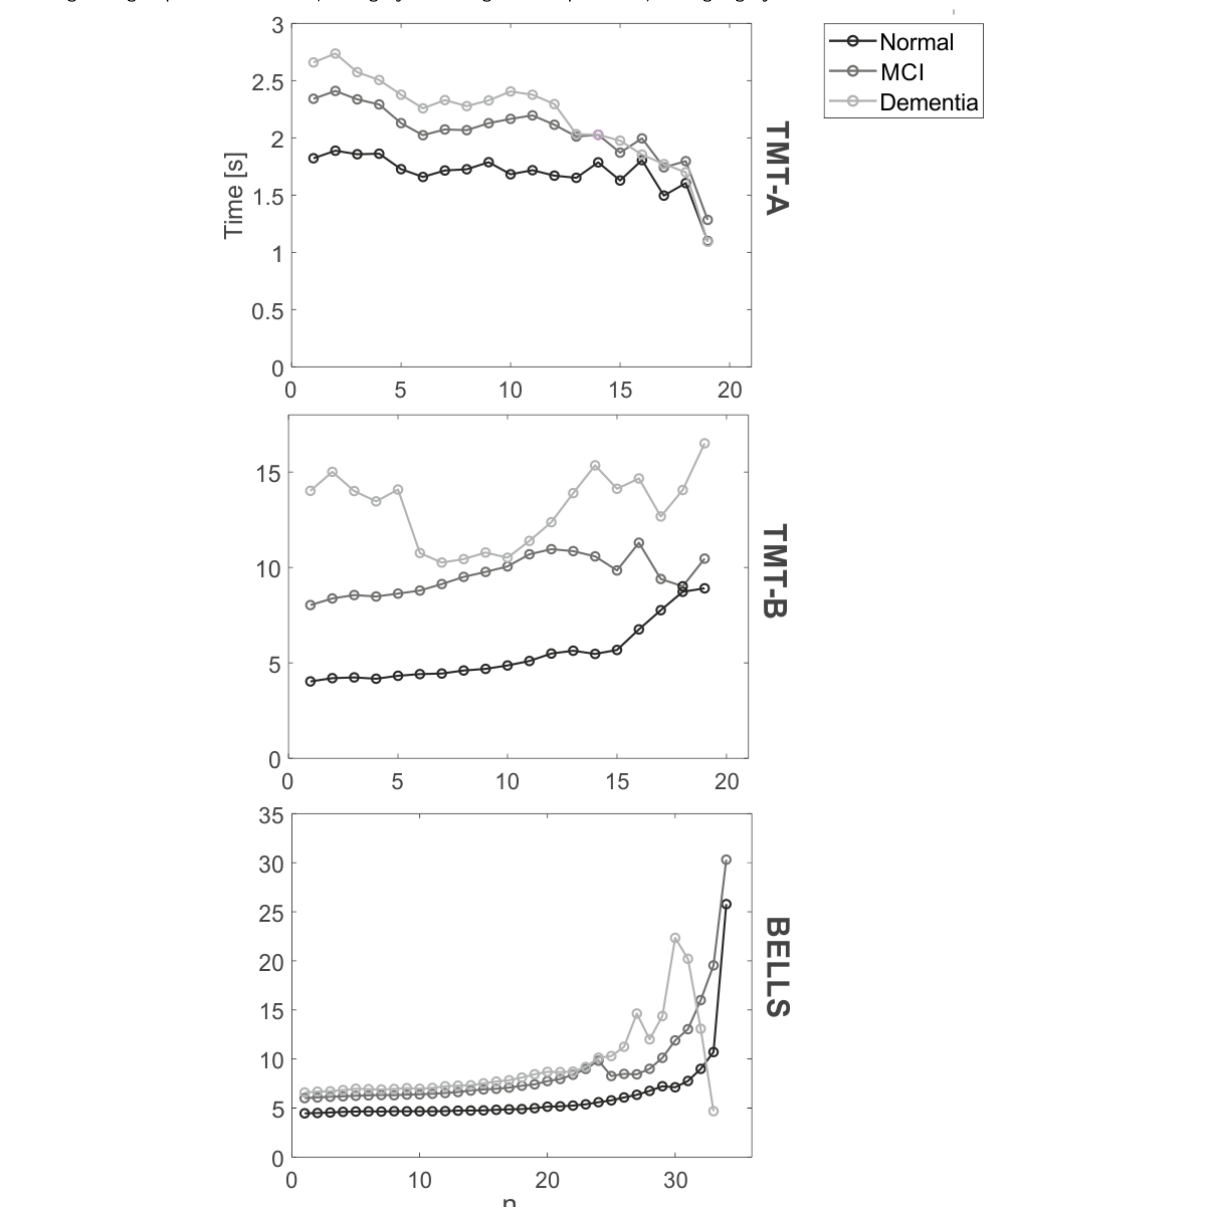
Figure 5. From top to bottom, Δ T_n for Trail Making Test (TMT)-Part A, TMT-B, and Bells Test. For each test, the 3 lines represent the average Δ T_n over the diagnosis groups (black: normal; dark gray: mild cognitive impairment; and light gray: